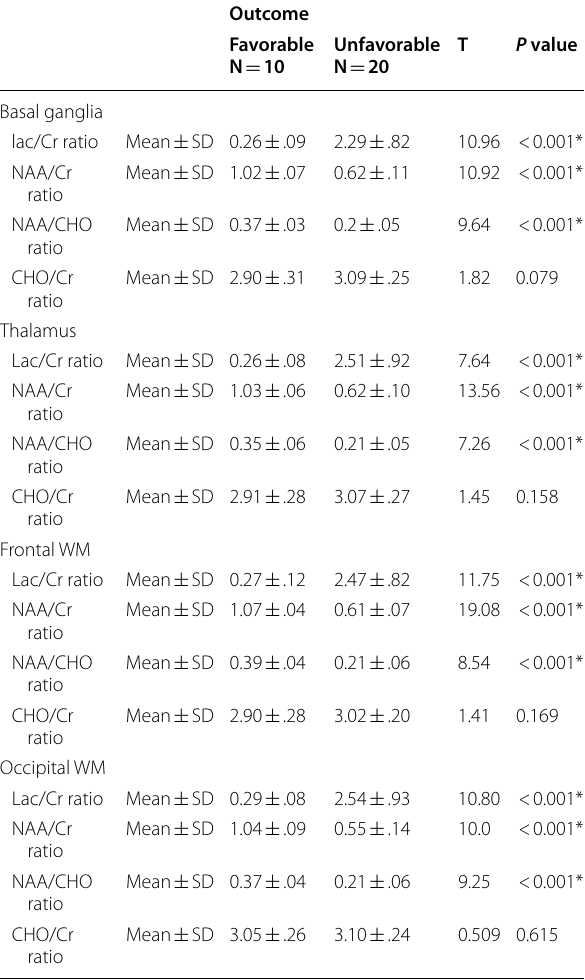
unfavorable outcomes regarding the studied ratios at the various studied